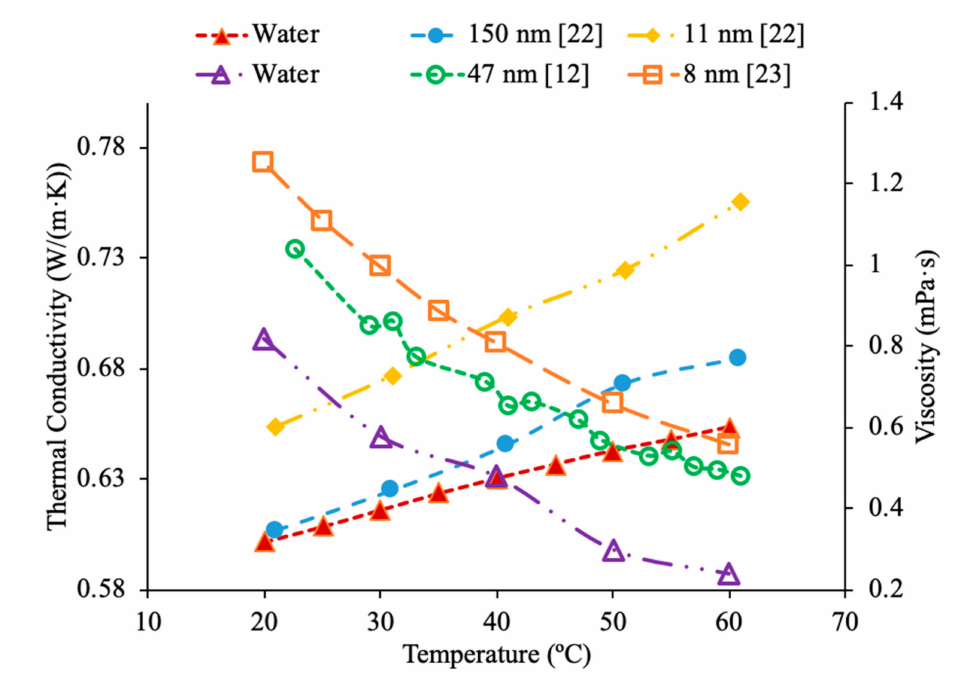
Figure 11. Thermal conductivity (increasing with temperature) and viscosity (decreasing with temperature) of various water-based nanofluids at 1% volume fraction and different sized nanoparti- cles